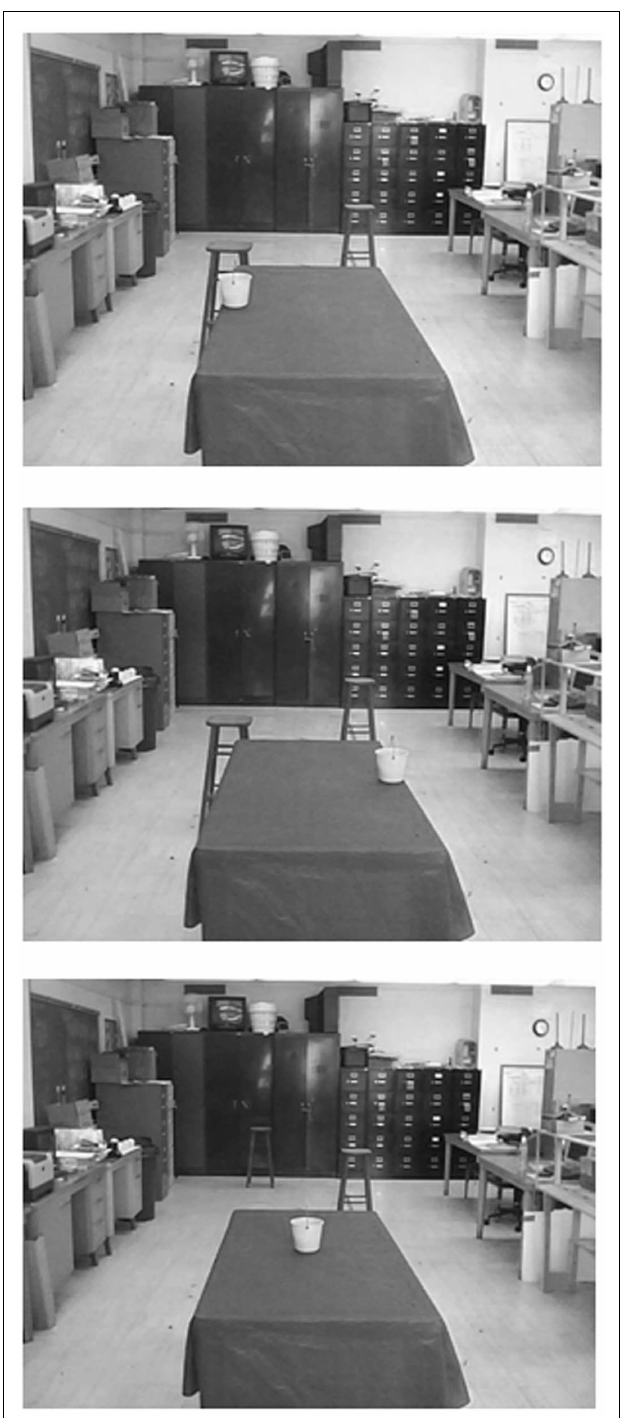
FIGURE 12 |Three arrangements used by Rosenbaum et al. (2011) to study walking and reaching . In all cases, the participant stood at the site where these photographs were taken. Top panel : bucket near the left edge of the table and the left target stool is nearby. Middle panel : bucket near the right edge of the table and the left target stool is again nearby. Bottom panel : bucket in the middle of the table and the right target stool is nearby. Adapted from Rosenbaum (2012).